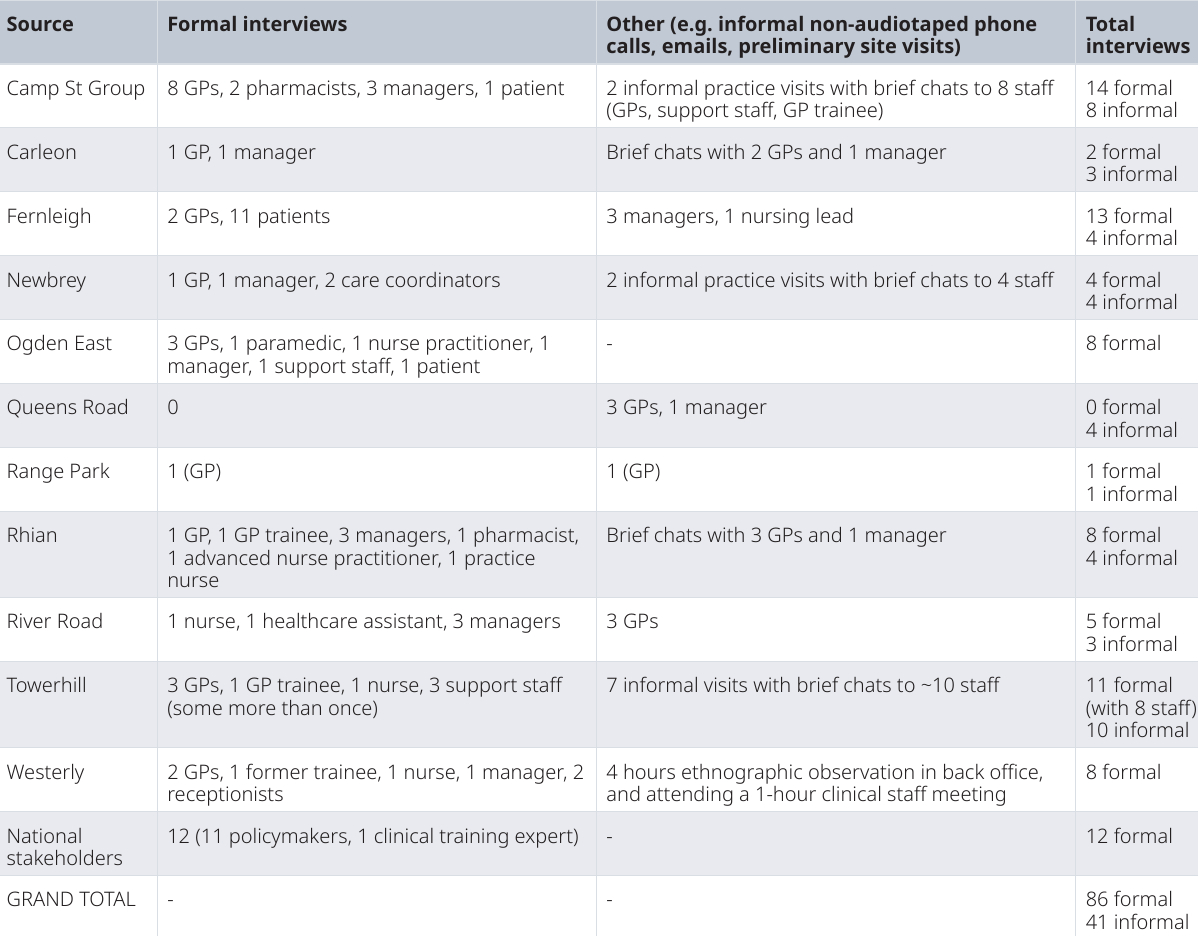
Table 1. Data sources for baseline findings reported in this